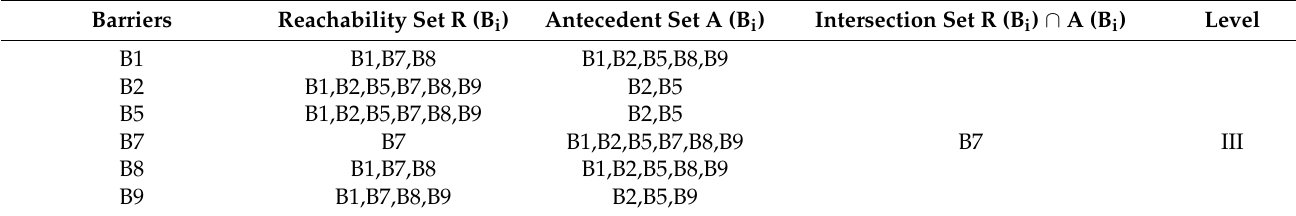
Table A3. Level partition iteration III.